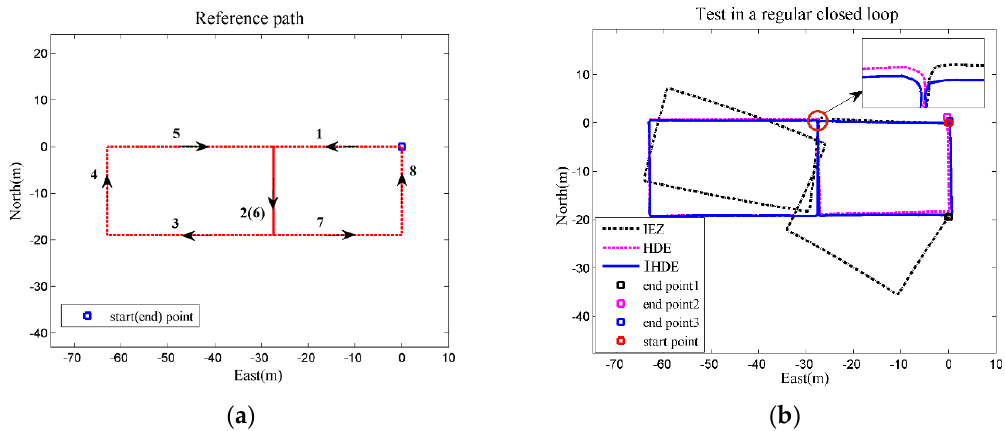
Figure 6. ( a ) The reference path in Test 1; ( b ) Estimated trajectories for Test